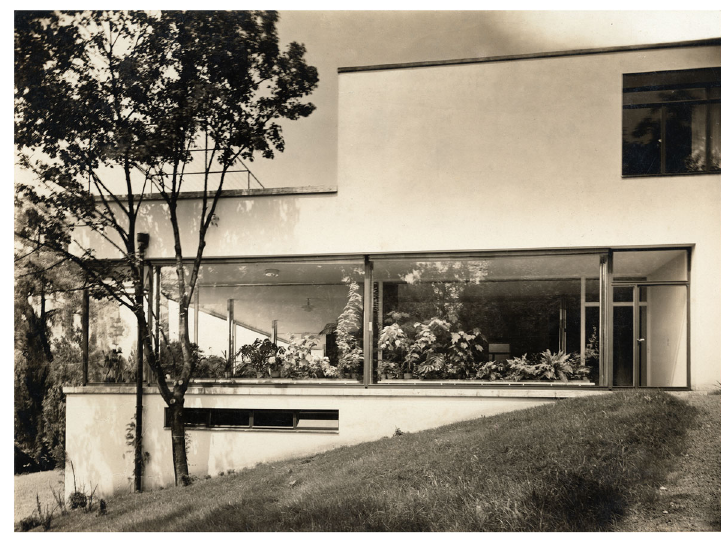
Fig. 6 Ludwig Mies van der Rohe and Lilly Reich, Tugendhat House, Brno 1930, south-east-facade; The photo has been retouched to eliminate elements of the facture and aging on the plaster surface (Source: Rudolf de Sandalo, Brno 1931)